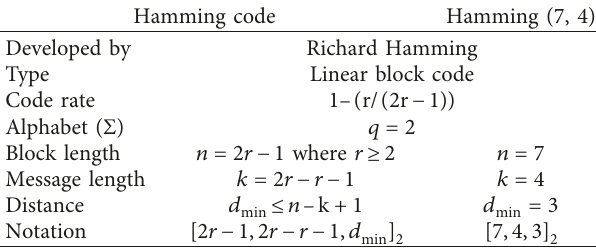
Table 1: Hamming code classification and